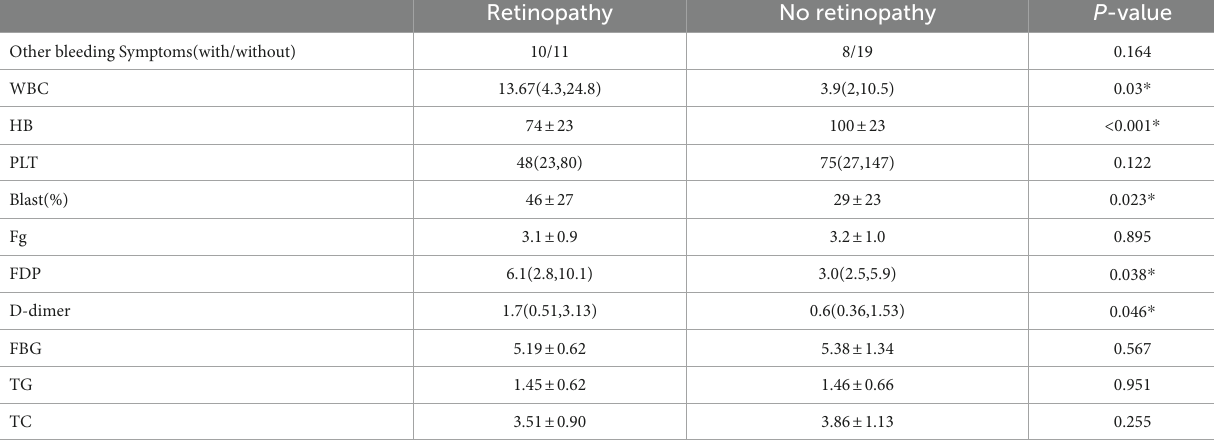
TABLE 2 Comparison of basic information and hematologic parameters between the retinopathy and no retinopathy